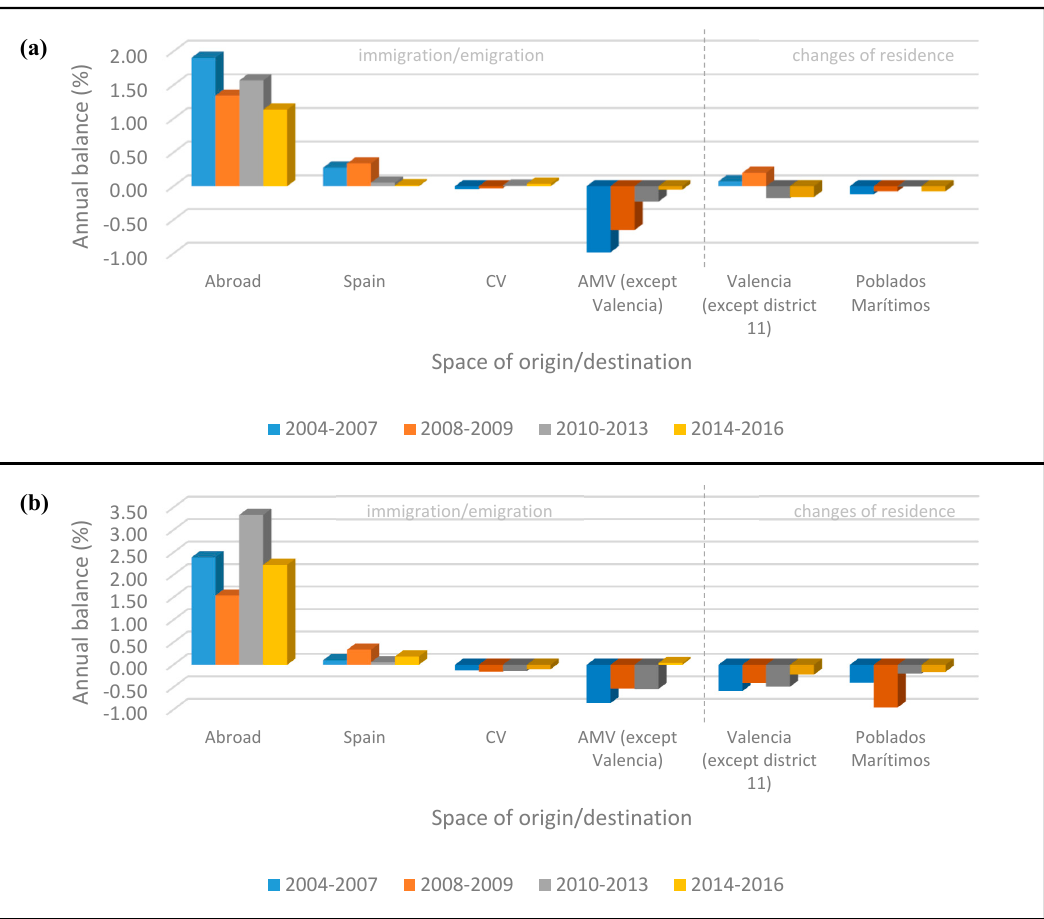
Figure 4. Total balance in Cabanyal ( a ) and in zone 0 ( b ) according to spaces of origin and destination, 2004–2016.